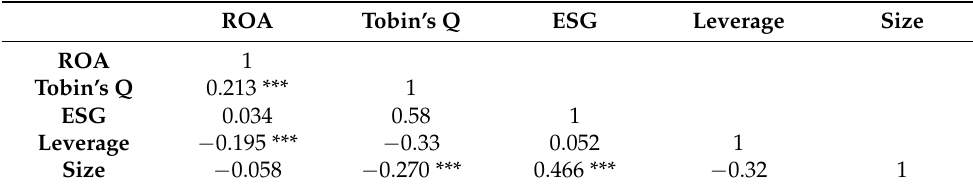
Table 7. Pearson Correlation Matrix.